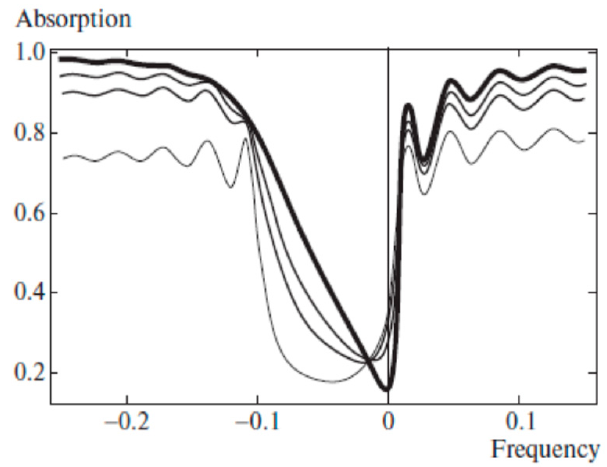
Figure 5. Absorption of light with diffracting circular polarization for a CLC layer with local anisotropy of absorption versus the frequency for S = 0, 0.3, 0.5, 1 (the curve thickness is growing with an increase in S) at Im[ ϵ 1 ]/Re[ ϵ 0 ] = 0.03, δ = 0.05, N = 50. Figure 6 presents KL fluorescence spectra of a perfect CLC layer for light with diffracting circular polarization at various values of the order parameter S.